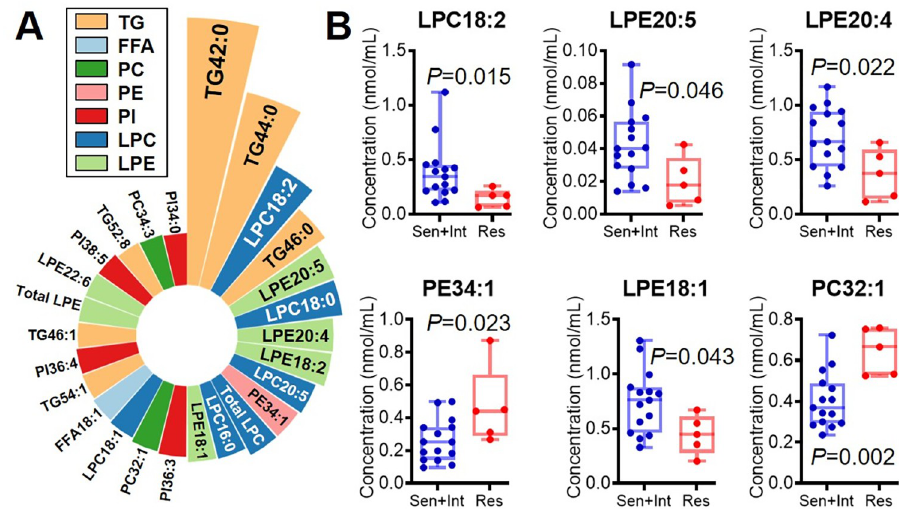
Fig 2. The Nightingale’s rose diagram of the top differentiated lipid species (A) and the comparison of the distinguished lipid species (B) between IVIG-sensitive + intermediate and IVIG-resistant groups before treatment.